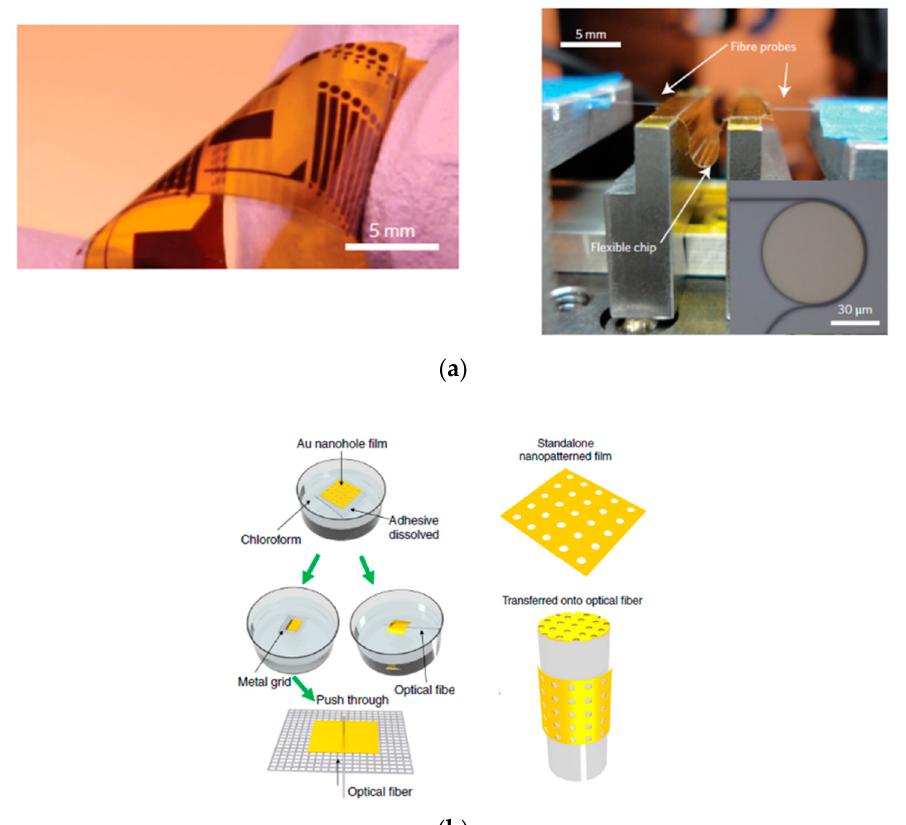
Figure 2. Examples of application of PSA tape to the construction of optical devices. ( a ) Left: Photograph of a flexible photonic chip built on a Kapton PSA tape substrate. Right: Photograph of a fiber end-fire testing set-up used for in situ measurement of optical transmission characteristics during mechanical bending of the flexible devices. Reprinted from [23] by permission from Springer Nature. ( b ) Schematic of a release-and-transfer process of an Au nanohole film to an optical fiber surface. Reproduced from [22] under a Creative Commons Attribution 4.0 International License (http://creativecommons.org/licenses/by/4.0/).